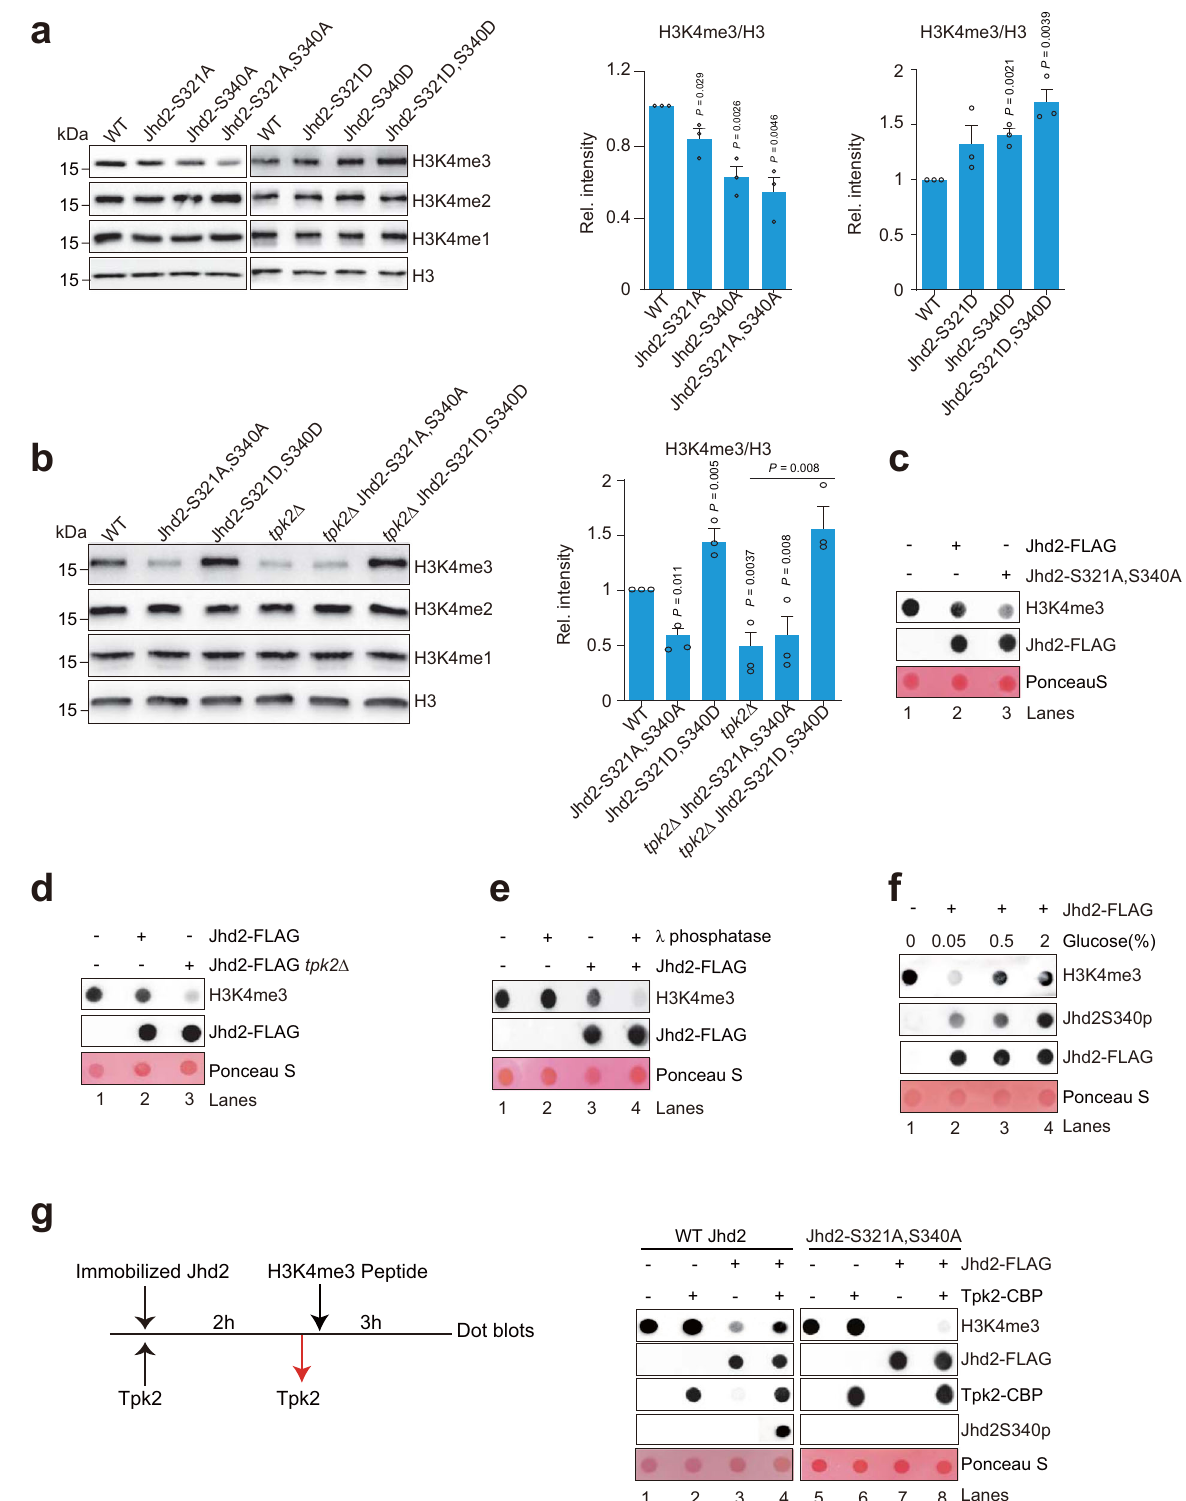
Fig. 3 | Tpk2-catalyzed Jhd2 phosphorylation inhibits the H3K4 demethylase activity of Jhd2. a Western blot analysis of H3K4 methylation in WT, Jhd2-S321A, Jhd2-S340A, Jhd2-S321A, S340A, Jhd2-S321D, Jhd2-S340D, and Jhd2-S321D, S340D mutants. b Western blot analysis of H3K4 methylation in WT, Jhd2-S321A, S340A, Jhd2-S321D, S340D, tpk2 Δ , tpk2 Δ Jhd2-S321A, S340A, and tpk2 Δ Jhd2-S321D,S340D mutants. c , d Analysis the activity of Jhd2 puri fi ed from WT (Jhd2-FLAG), Jhd2- S321A, S340A (Jhd2-S321A, S340A-FLAG), and tpk2 Δ (Jhd2-FLAG tpk2 Δ ) on H3K4me3 (1 – 23) peptide by in vitro histone demethylase assay.